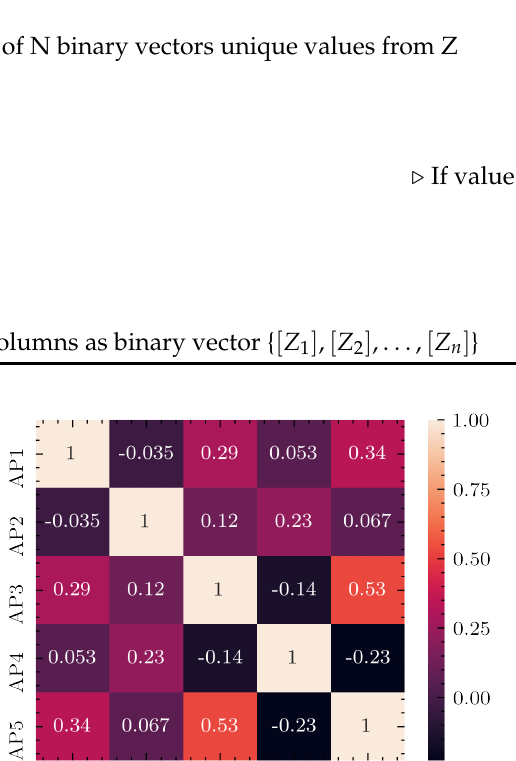
Algorithm 2: One hot Encoding